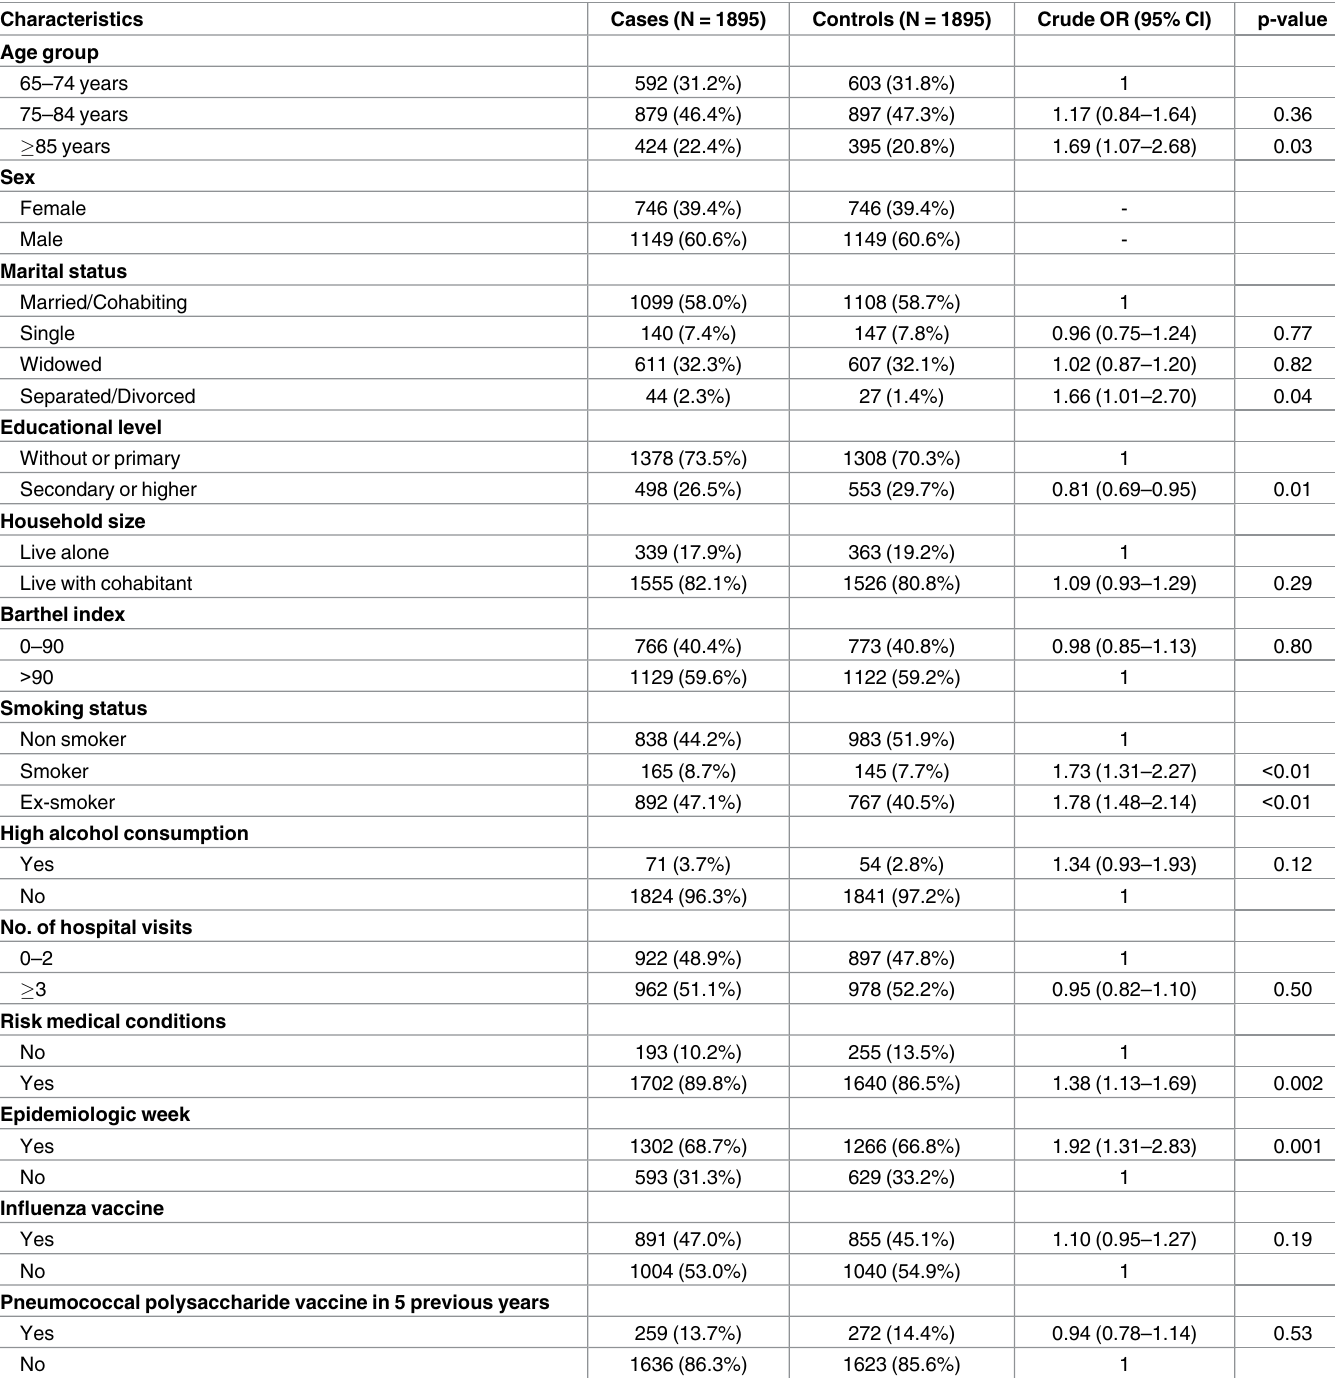
Table 1. Distribution of cases and controls according to demographic variables, medical conditions and vaccination